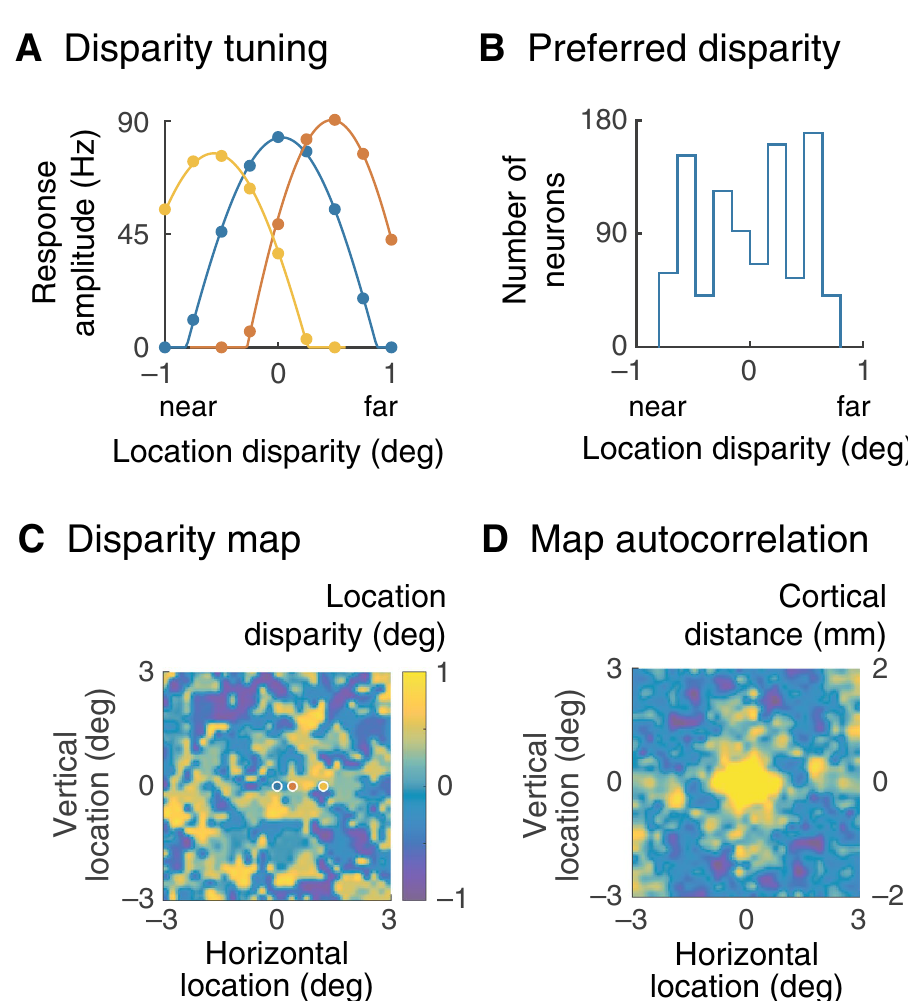
Figure 6. Binocular disparity. The stimuli during the binocular phase of development were spatially offset to simulate instability in binocular fixation. This resulted in neurons that differed in their preferred binocular disparities. ( A ) Disparity tuning is shown for three cells, in differing colours, to exemplify tuning for points nearer and further than the fixation plane, and on the plane. Cell location is shown in ( C ) of the figure. Disparity is measured as visual field distance perpendicular to grating bars. The stimuli were cyclic in time, and the response is therefore also cyclic; only one half-cycle of the response is shown. The stimuli were also cyclic in space, and the horizontal axis spans one period of the stimulus. The fitted curve is a rectified sinusoidal function, as described in the Methods. ( B ) The histogram of preferred disparity shows a spread across almost two degrees of location disparity, consistent with empirical findings. ( C ) Mapping preferred disparity across the visual field shows clusters of cells that prefer either near or far disparities, suggesting a columnar structure. ( D ) Periodicity in preferred disparity was measured with the autocorrelation of the map in ( C ). The conversion from degrees of visual angle, left axis, to cortical distance is shown on the right axis. The light areas around the central peak indicate a mean periodicity of 1.0